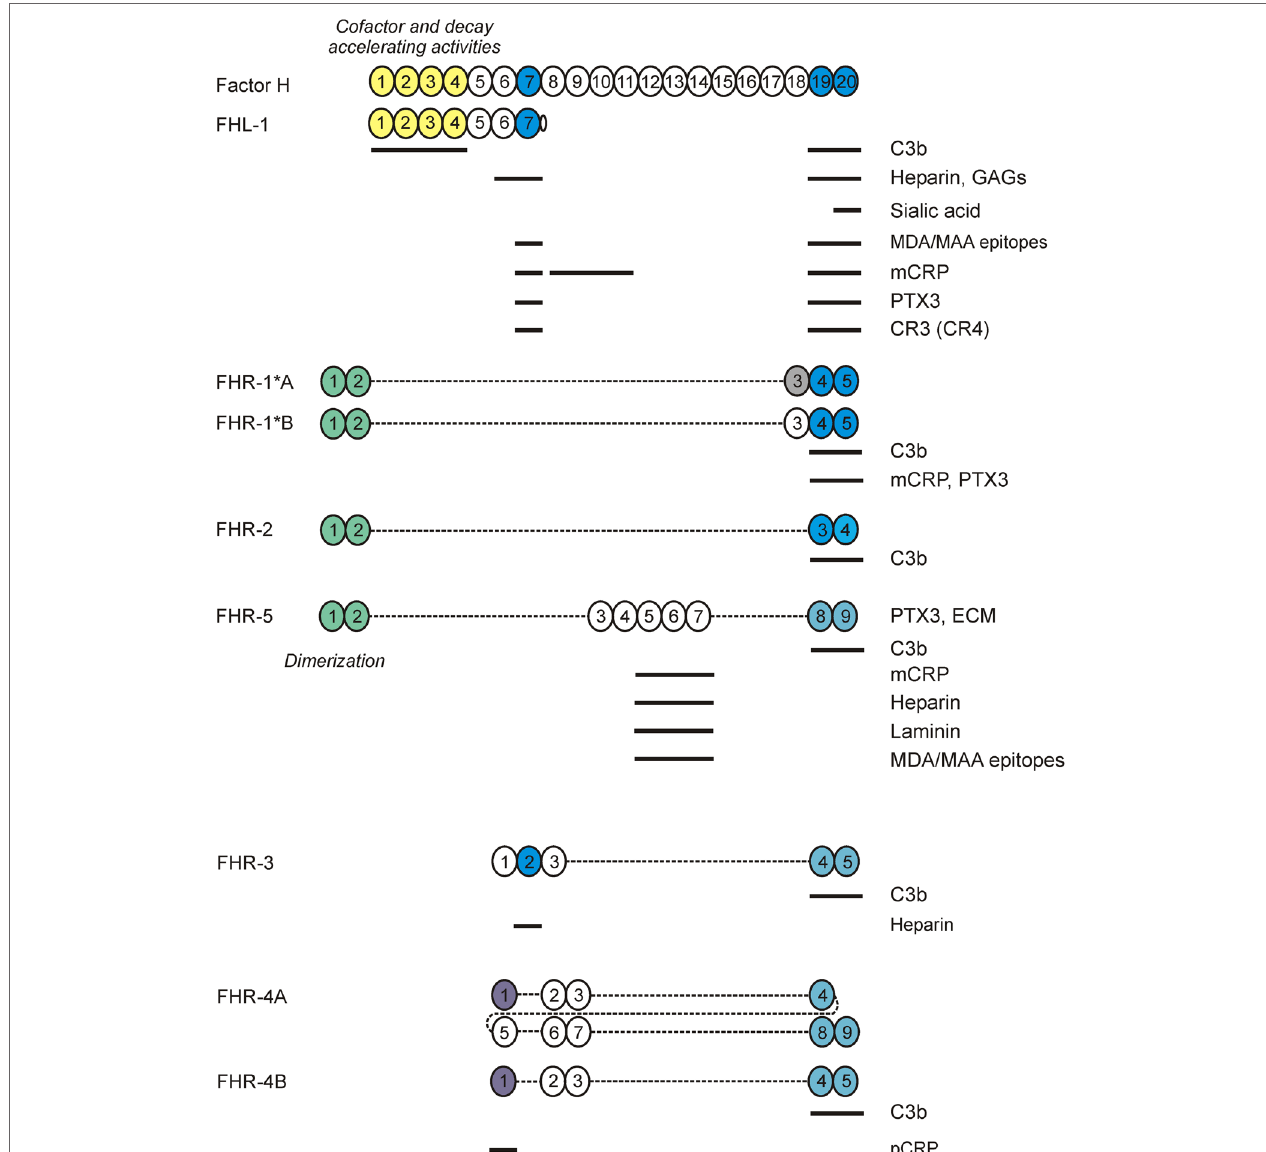
FigURe 2 | Factor H (FH) family proteins and their ligands. The schematic complement control protein (CCP) domain structure of FH, FHL-1, and the FHR proteins is shown, with CCPs aligned vertically to the homologous domains in FH. The N-terminal CCPs 1–4 of FH and FHL-1 mediate the complement regulatory functions of these proteins (shown in yellow). CCPs 7 and 19–20 (shown in blue) harbor the main ligand- and host surface-recognition sites; selected ligand binding sites are indicated by horizontal lines. The CCPs 1–2 of factor H related protein 1 (FHR)-1, FHR-2, and FHR-5 are closely related to each other and mediate dimerization of these FHRs. The CCPs in FHRs with high sequence identity to the homologous FH domains are indicated by identical/similar